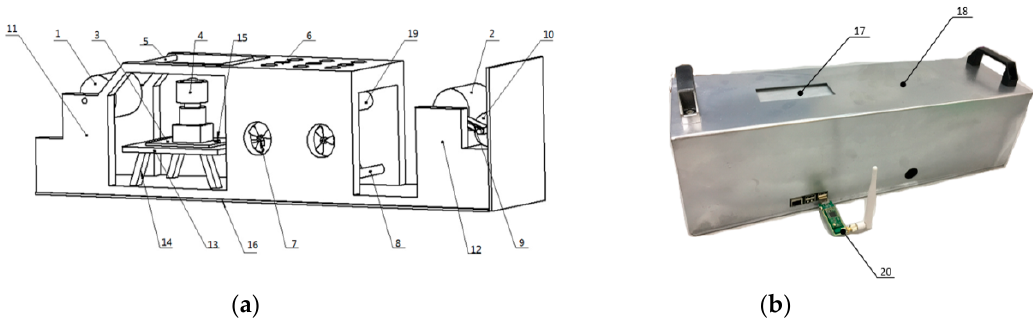
Figure 1. Collection device structure. ( a ) Internal structure; ( b ) External structure. Note: 1. Released